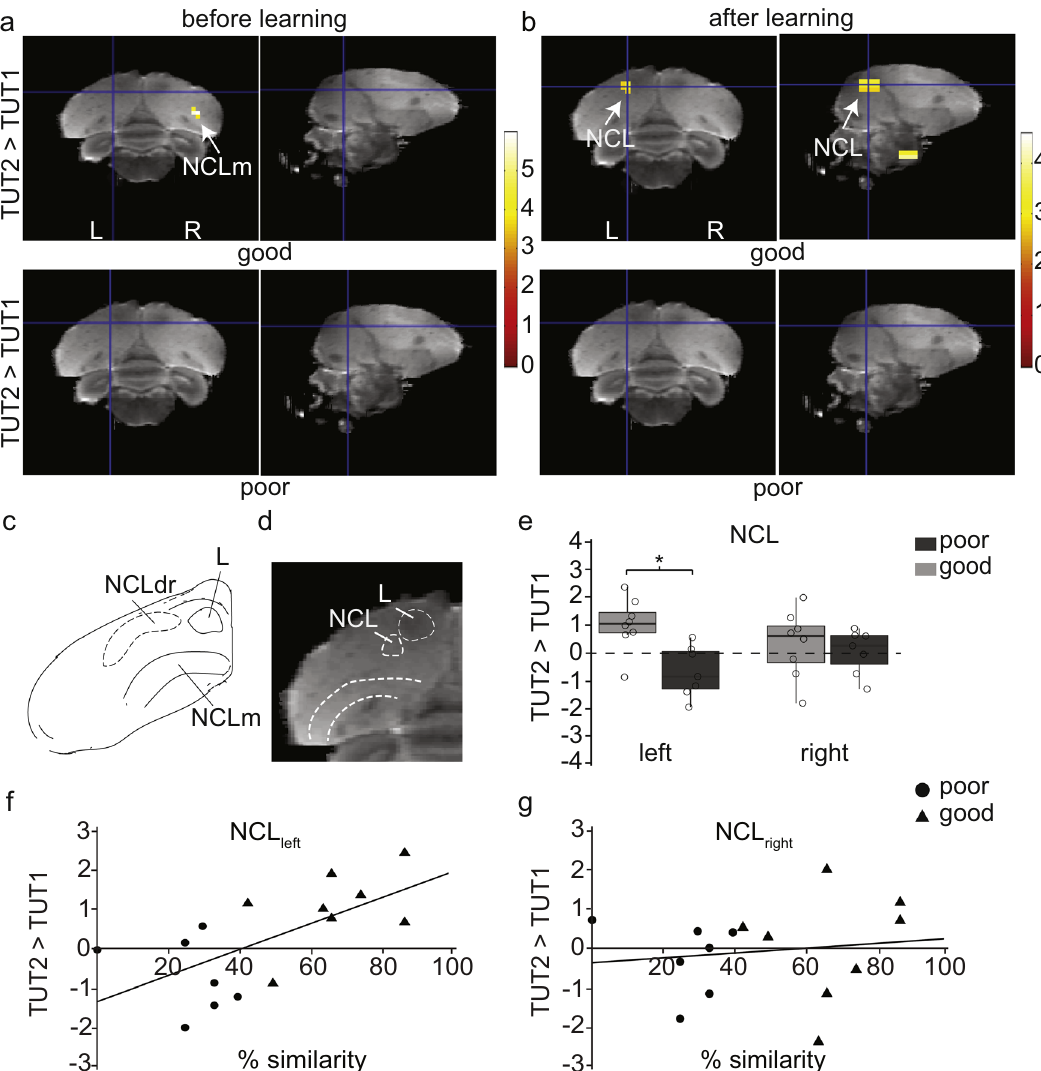
Fig. 5 Good learners show a selective response in the NCL after learning the second-tutor ’ s song, as compared to poor learners. a Before exposure to the second-song tutor, there is already a TUT2-selective response (TUT2 > TUT1; all voxels with t > 2.65, P uncorrected < 0.01 are displayed) in the nidopallium in juveniles which go on to learn well from the second tutor (good learners), as compared to those which do not (poor learners). b After exposure to the second-song tutor, there are TUT2-selective responses (TUT2 > TUT1; all voxels with t > 2.65, P uncorrected < 0.01, are displayed) in part of fi eld L (L2a) and part of the NCL in adults that successfully imitated TUT2 song (good learners) compared to poor learners. Statistical map of voxels superimposed on a high-resolution MRI atlas of the zebra fi nch brain. c Line drawing of a coronal section (A1.35) from the zebra fi nch stereotaxic atlas 89 showing the areas NCLdr (lateral to fi eld L) and NCLm, based on tyrosine hydroxylase (TH) positive fi ber distribution within the caudal nidopallium (adapted from refs. 22,89 ). d Detailed view of the exact location of the cluster observed within the NCL of good learners in ( b ). e BOLD response ( β weights) between different stimuli in the cluster indicated with a white arrow in 5b after learning the second-tutor song. Boxplots showing the interquartile range (box), median (black line), 1st and 3rd quartile, and all data points (* P uncorrected < 0.01, N = 15). f , g After learning the second-tutor song, in adult birds, the strength of TUT2-selective signals in the left NCL (F, NCL left : r = 0.64, P = 0.01), but not in the right NCL (G, NCL right : r = 0.13, P = 0.63), was related to the fi delity of song imitation. The regression line is shown for good and poor learners. TUT2 selectivity is expressed as the mean amplitude estimate of differential BOLD signals of [TUT2 minus TUT1] in non-dimensional units. % Similarity is expressed as the percentage of shared elements between the tutee ’ s song and the second-tutor ’ s song. The median similarity score was used to divide birds into “ good ” learners (scores higher than the median) and “ poor ” learners (scores lower than the median). Black triangles represent birds with good imitation scores and black circles represent birds with poor imitation of the second-tutor song. NCL: caudolateral nidopallium, NCLdr: rostral aspect of the dorsal caudolateral nidopallium, NCLm: medial aspect of the caudolateral nidopallium, L: fi eld neural processes that could cause a negative BOLD response. responses while listening to NOV songs. Positive BOLD However, it is interesting to note that both TUT1 and TUT2 show responses re fl ect increased neural activity, but negative BOLD positive BOLD responses in the same region where NOV songs responses could either be because of decreased neural show no BOLD response or a negative BOLD response. This may activity 48 – 51 or “ vascular steal ” 52 . The BOLD responses to NOV represent neuroadaptive changes associated with learning, songs in MLd are characterized by large variability between birds through which the TUT songs become more salient because of and may not be robust enough to speculate about the underlying